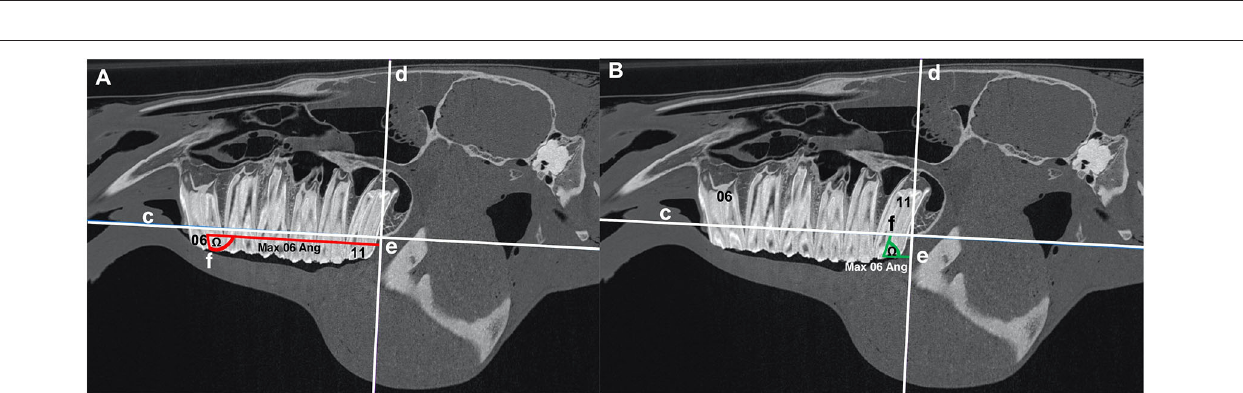
sizes, adjusted rostro-caudal position measures, and adjusted row lengths were calculated (“adjusted measures”) by scaling to the mean measured head size of the